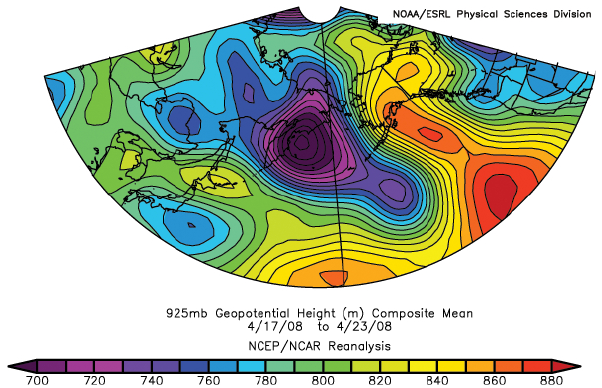
Fig. 21. Mean 925 hPa geopotential height (m) pattern, 17–23 April. This period was dominated by the incursion of a large low pres- sure system from the west into the Bering Sea. The anomalous high was displaced to the east. The resulting strong flow from the south brought a pronounced warming trend to the Interior. As the low moved in it displaced the main trajectory progressively farther to the south, increasing transport distance and showing up as a steady decrease in wildfire species into late